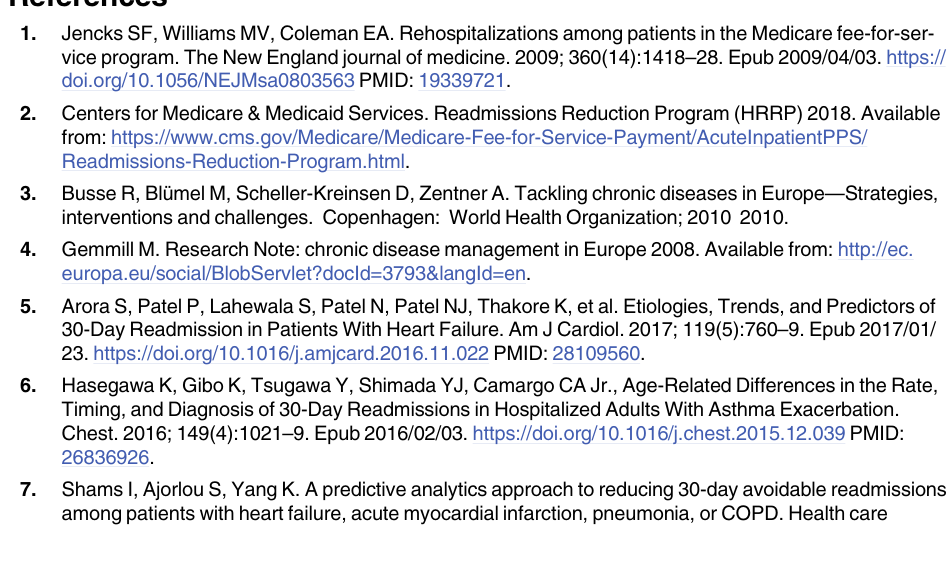
S2 Table. ICD 9 and ICD 10 codes for chronic conditions. S1 Fig. A and B: Link between original condition of admission (left side) and cause of read- mission (right side) for each chronic condition. B provides information about all other causes in A. Interactive online figures to provide a dynamic depiction of the different causes of read- mission for each chronic